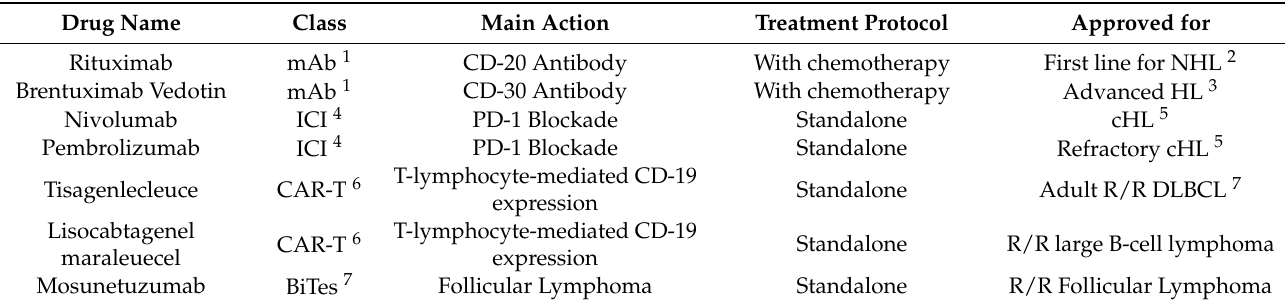
Table 1. List of approved immunotherapies for